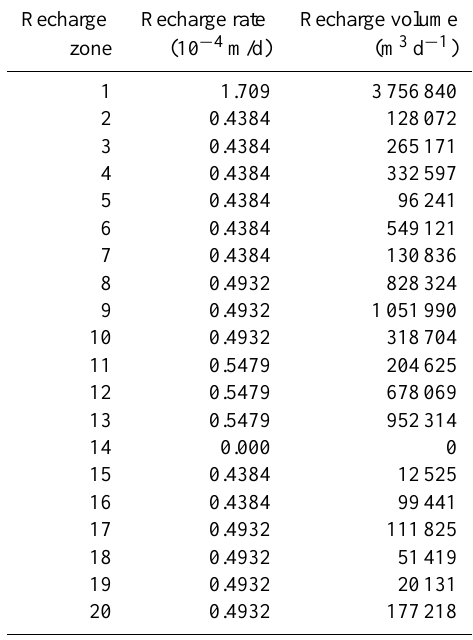
Table 1. Recharge rates and volumes over each simulated recharge area.